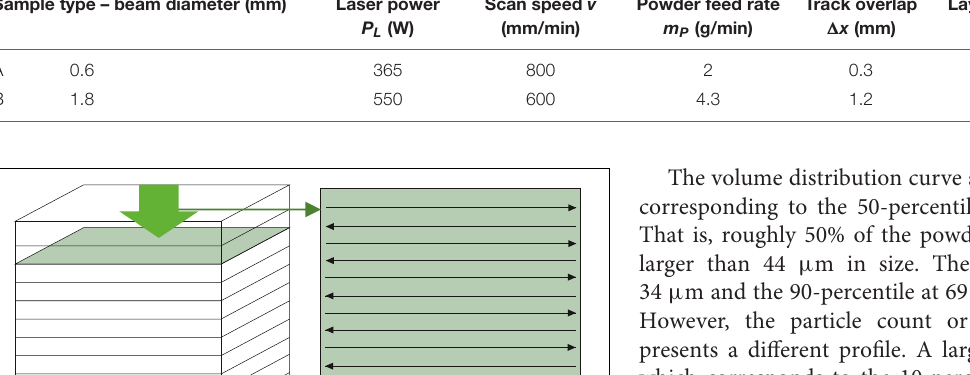
TABLE 1 | Laser material deposition (LMD) process parameter sets for A- and B Sample production. Sample type – beam diameter (mm)